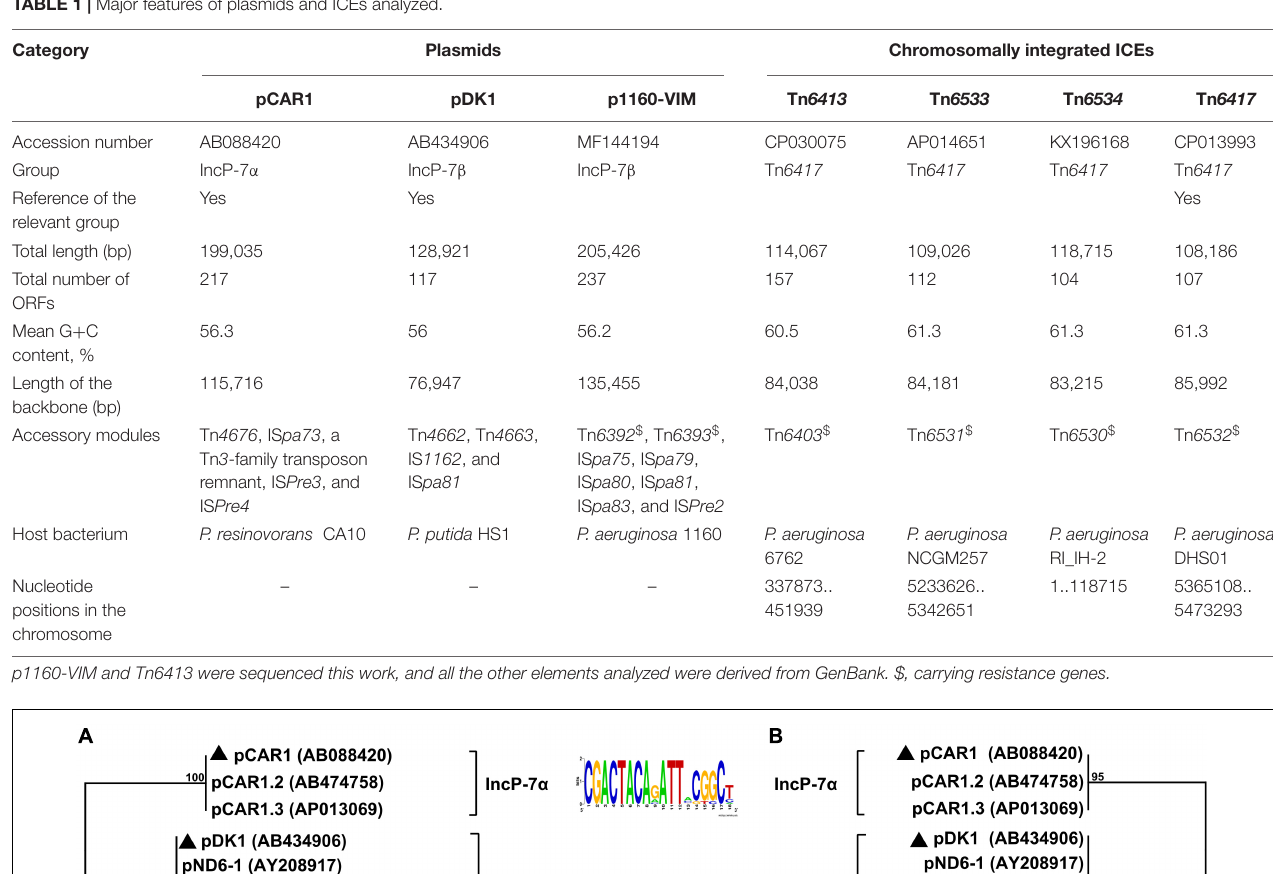
TABLE 1 | Major features of plasmids and ICEs analyzed.